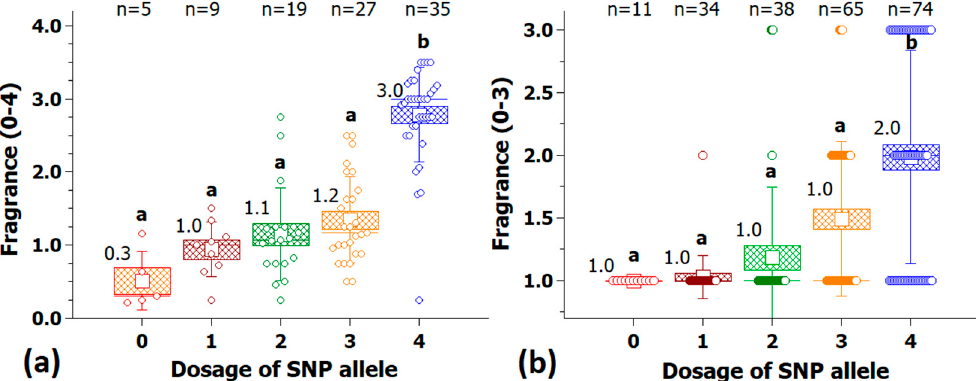
Figure 9. Validation of the KASP marker Rh_FR_SNP139K (Chr 2, 72.49 Mbp) for fragrance with 95 cultivars in the association panel ( a ) and with 222 independent tetraploid cultivars ( b ). On the x -axis are the allelic dosages for the four marker classes (0 and 4 for the homozygote classes and 1–3 for the heterozygotes), and on the y -axis, the fragrance score. For each allele dosage group, the number of individuals (n) is given on top; groups that are significantly different at p ≤ 0.05 are indicated by letters above the whiskers (Kruskal-Wallis rank sum test); median values are given above the box. Small white square = mean; continuous line = median; box = standard error; and whisker = standard deviation.